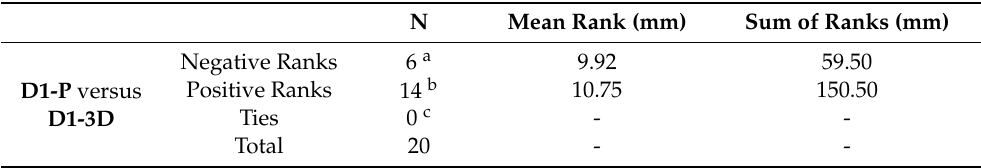
Table 3. Ranks regarding the D1-3D distances compared with the D1-P distances (the Wilcoxon Signed Ranks test results).